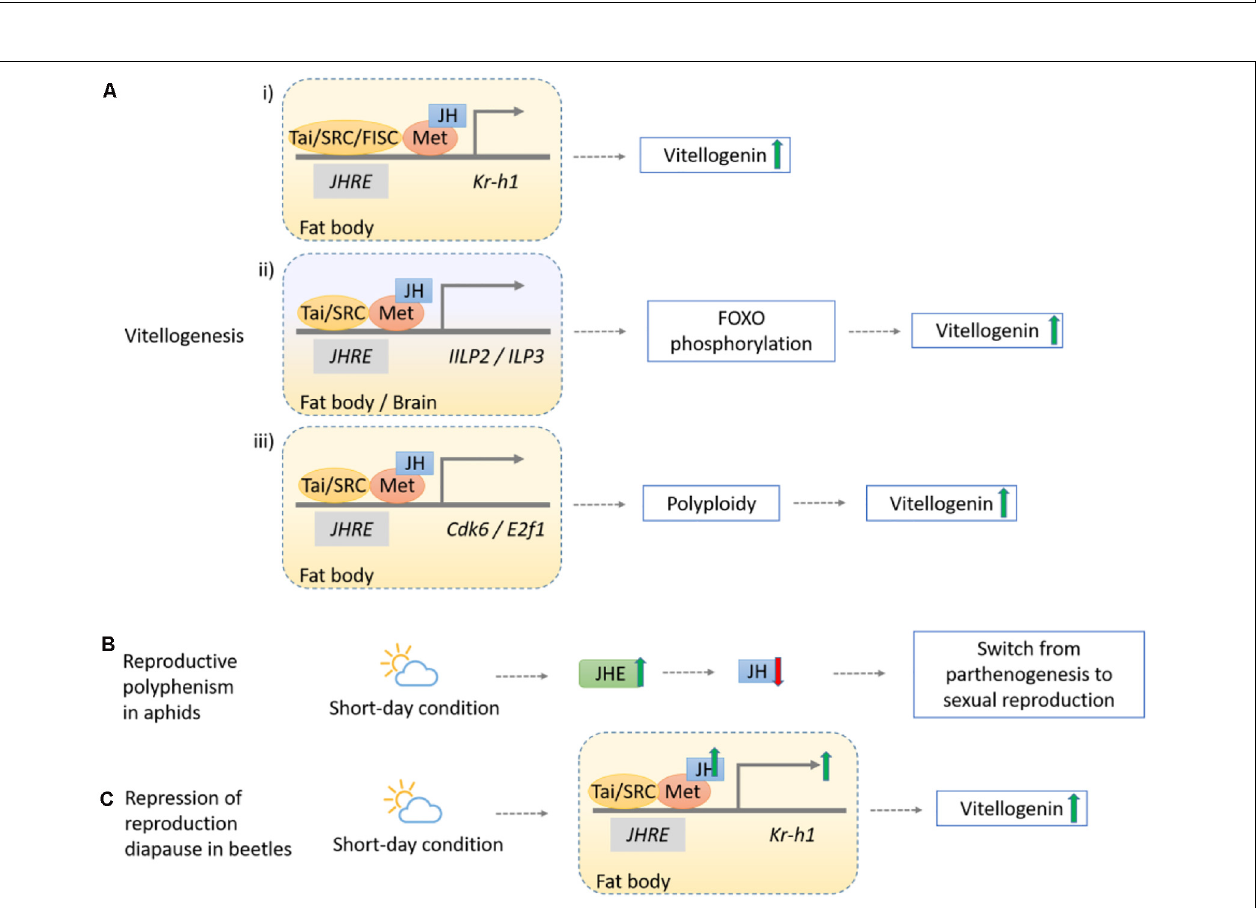
FIGURE 4 | Schematic diagram showing the mechanisms of sesquiterpenoids in regulation of insect reproduction . (Ai) The JH-Met-Tai/SRC complex upregulates Kr-h1 to increase Vg synthesis level, as observed in T. castaneum , A. aegypti (with an additional complex FISC), L. migratoria but not in P. apterus . (Aii) The JH-Met-Tai complex initiates transcriptions of ILP2 and ILP3 , which phosphorylates the fork head transcription factor (FOXO) through ILP signaling pathway and induces Vg expression in T. castaneum . (Aiii) The JH-Met-Tai/SRC complex promotes expression of core mediators in cell cycle progression, Cdk6 and E2f1 , to facilitate vitellogenesis in L. migratoria . (B) Reproductive polyphenism in aphid A. pisum occurs during the short-day condition given the increased JHE activity, and the lowering of JH result in the switch from parthenogenesis to sexual reproduction. (C) Repression of reproduction diapause in beetles C. bowringi initiates in short-day condition where the upregulation of the JH-Met-Kr-h1 pathway genes expression increases Vg synthesis.